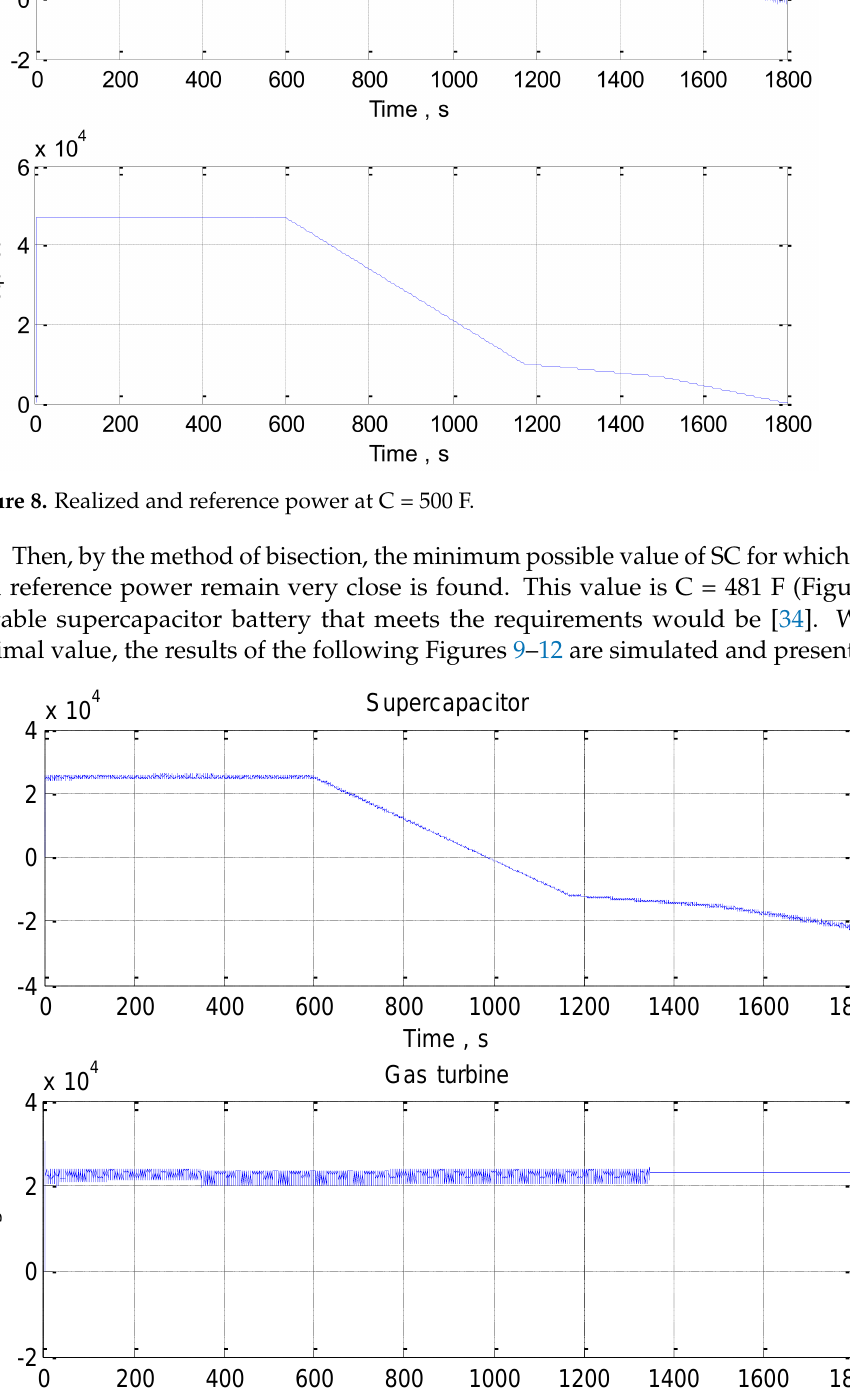
Figure 9. Realized power of supercapacitor and gas turbine at a minimum value of SC = 481F.